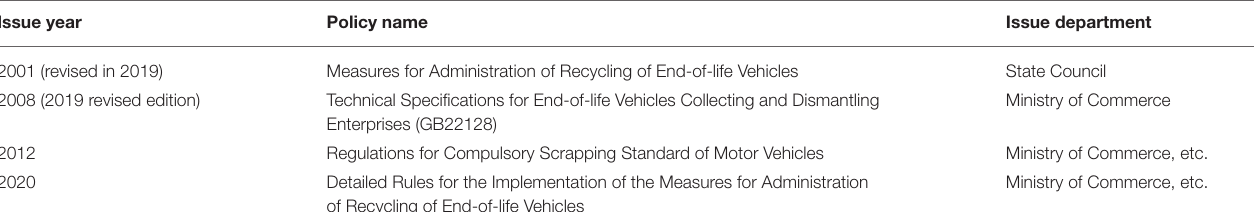
TABLE 4 | China’s policies and regulations on ELV recycling industry.